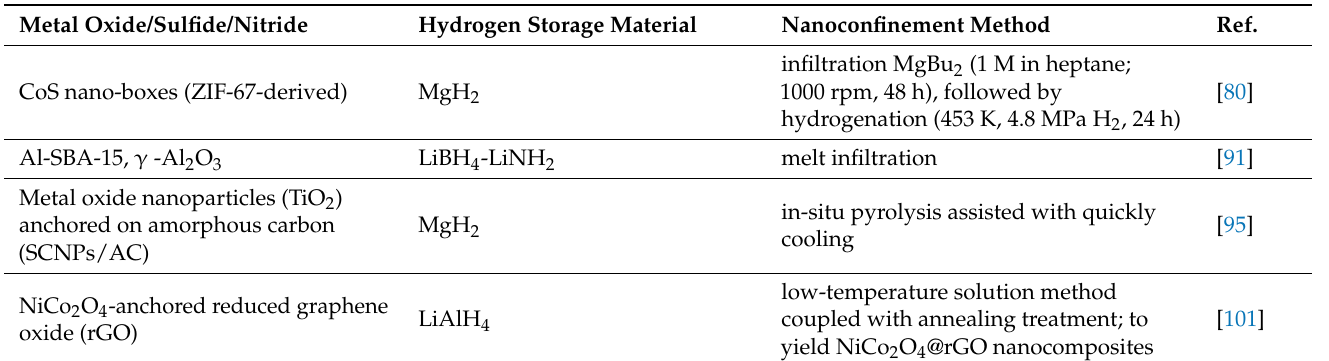
Table 4. Recent progress in oxides, sulfides and nitrides-based hosts for nanoconfined hydrogen storage